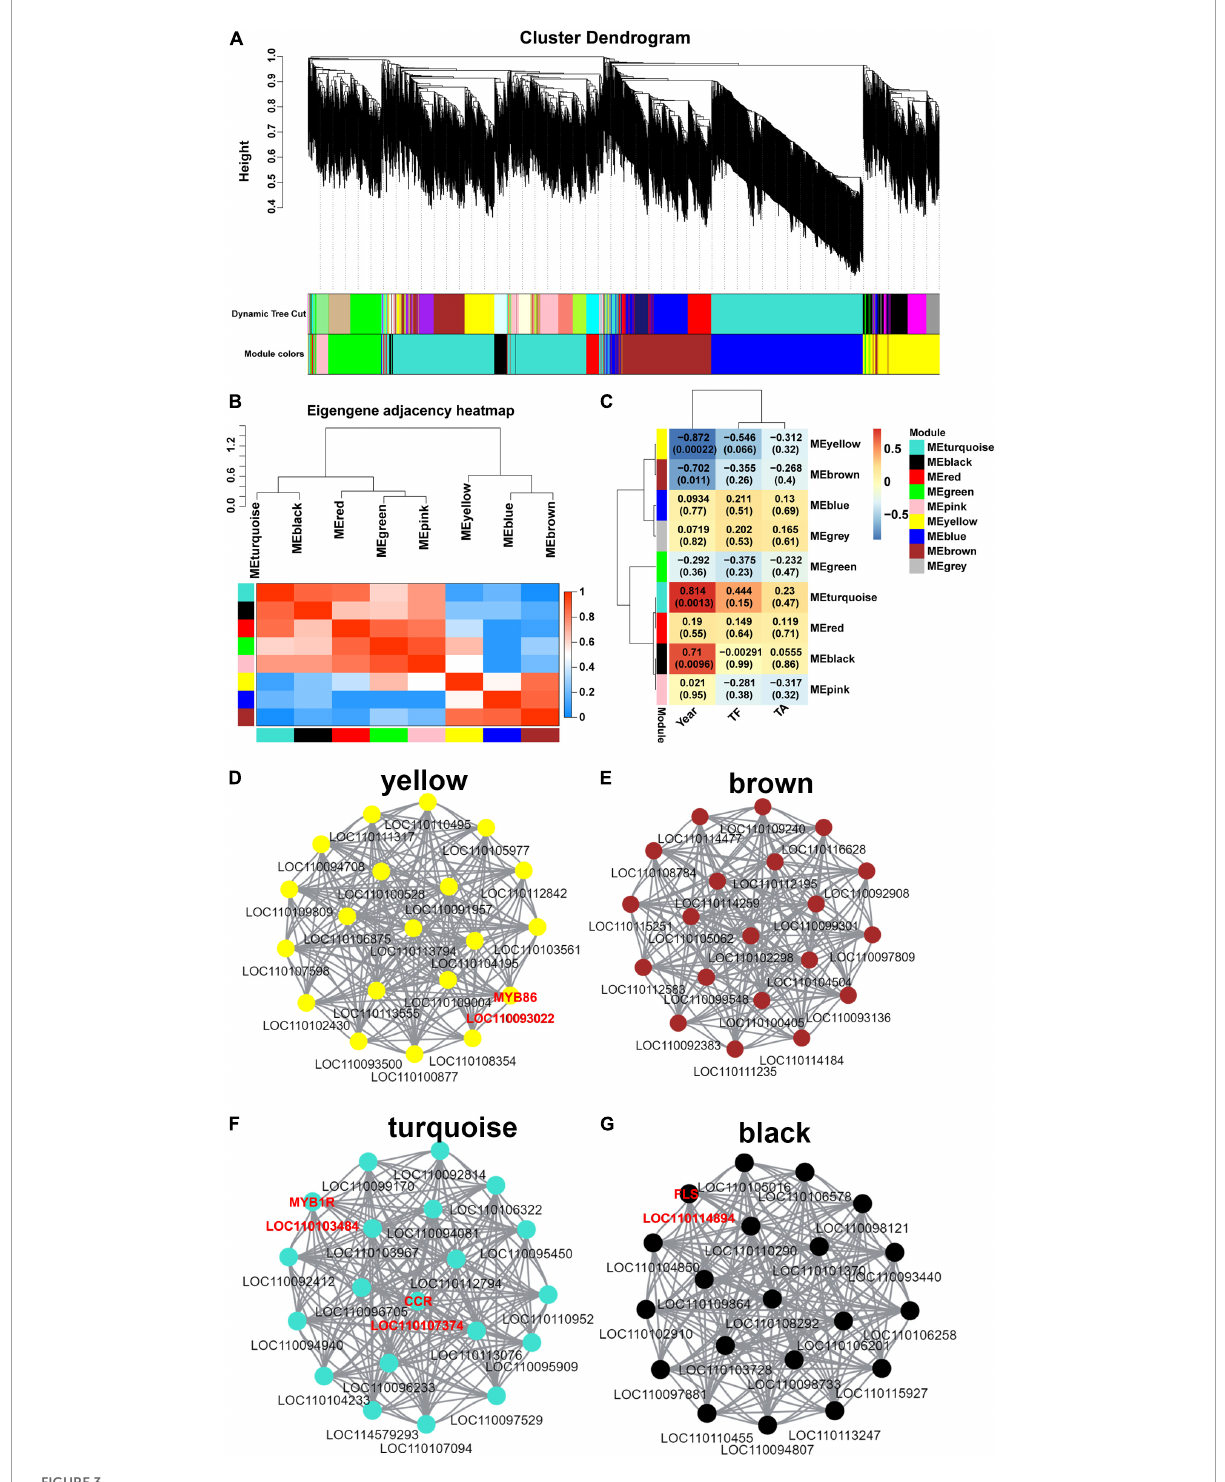
FIGURE3 Weighted gene co-expression network of D. moniliforme . (A) Clustering dendrogram of DEGs, with dissimilarity based on the topological overlap, together with assigned module colors. The clustered branches represent different modules, and each line represents one DEG. (B) The heatmap of connectivity of eigengenes. (C) Module-trait associations. Each row corresponds to a module characteristic gene (eigengene), and each column corresponds to a trait. Each cell contains a corresponding correlation coefficient and p -value. (D–G) D. moniliforme transcriptome co-expression network diagram: (D) Yellow module; (E) brown module; (F) turquoise module; (G) black